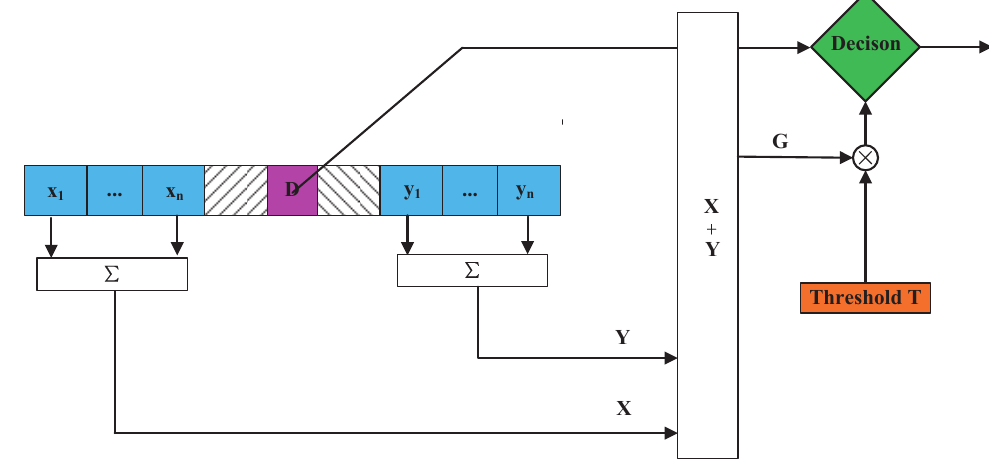
Figure 1. The structure of a 1D constant false alarm detection